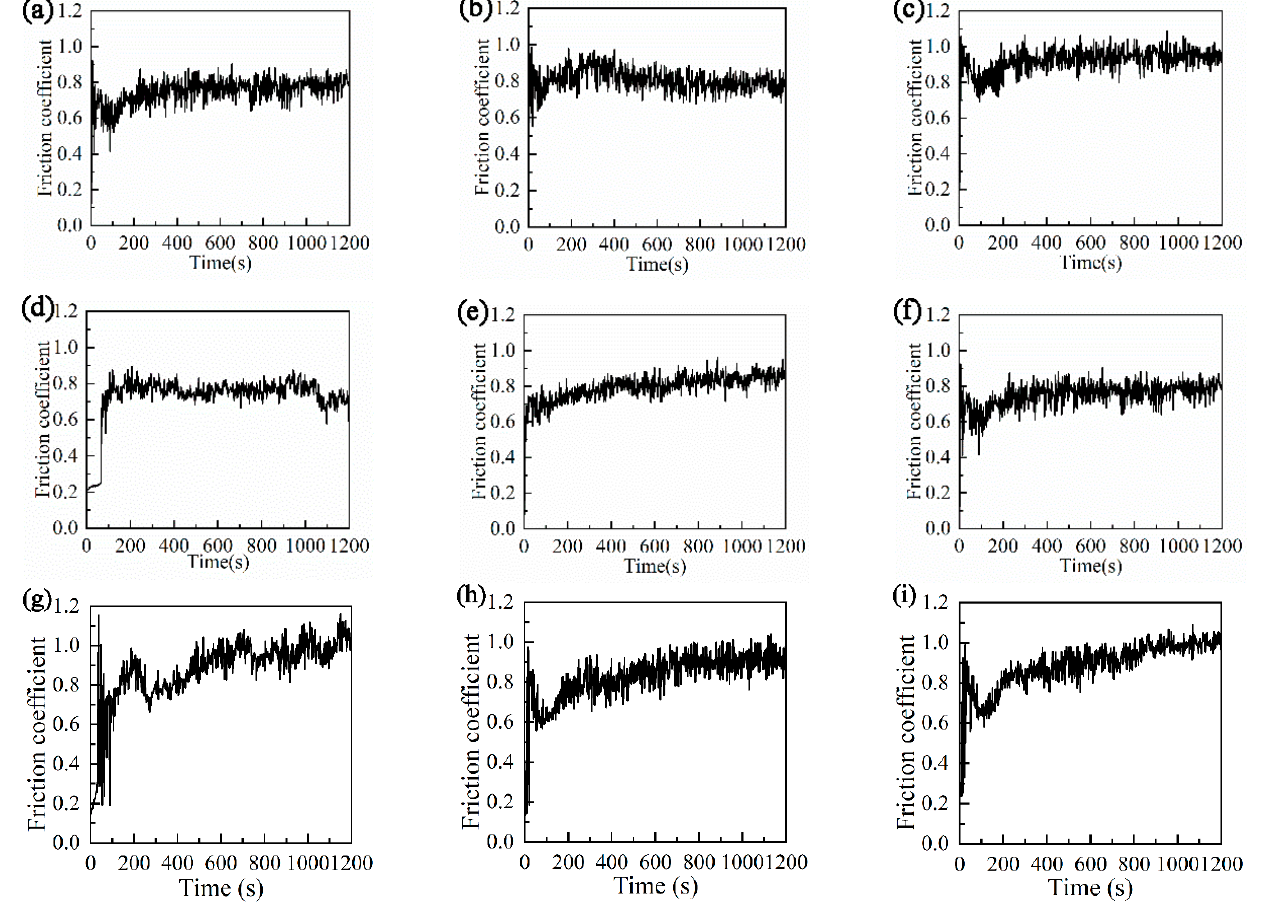
Figure 4. Friction coefficient curves of different samples: ( a ) nanosecond texture rotation radius 15 mm; ( b ) nanosecond texture rotation radius 18 mm; ( c ) nanosecond texture rotation radius 22.5 mm; ( d ) picosecond texture rotation radius 15 mm; ( e ) picosecond texture rotation radius 18 mm; ( f ) picosecond texture rotation radius 22.5 mm; ( g ) untexture rotation radius 15 mm;( h ) untextured rotation radius 18 mm; ( i ) untextured rotation radius 22.5 mm.